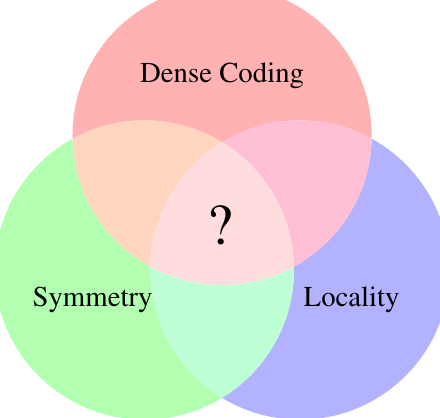
FIG. 1. The intersection of dense coding, symmetric encoders, and local decoders remains largely unknown. Better understand- ing this intersection would inspire more practical dense coding